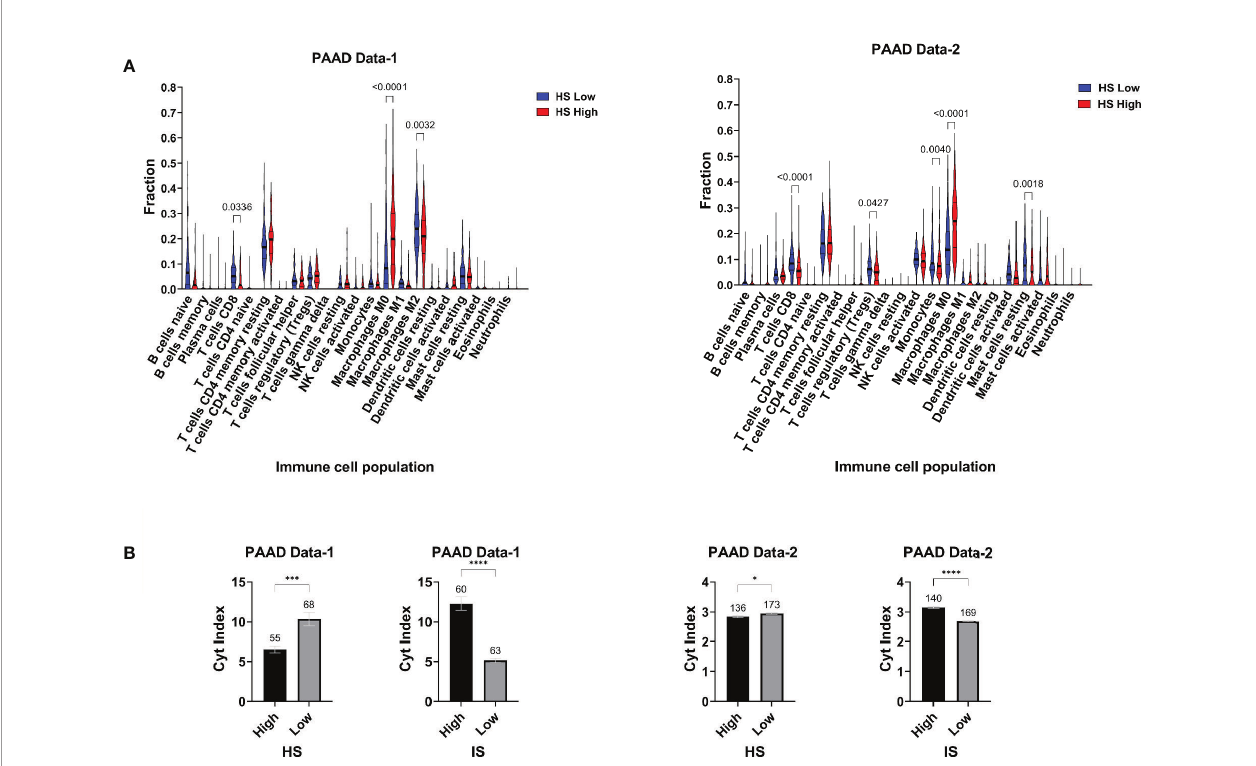
FIGURE 4 | Hypoxia-immune landscape of pancreatic cancer: (A) Violin plots of immune cell fractions determined by CIBERSORTx in hypoxia score (HS) low and high tumors. (B) Mean SEM of Cytolytic (Cyt) index in HS high and low tumors and in IS high and low tumors. Number of samples in each group is indicated above the error bars. Signi fi cance determined by ordinary one-way ANOVA with Bonferroni correction for multiple testing (A) and two-tailed unpaired t-test analysis (B) . P- value < 0.05 considered statistically signi fi cant. *p-value > 0.01; **p-value < 0.0021; ***p-value < 0.0002; ****p-value <